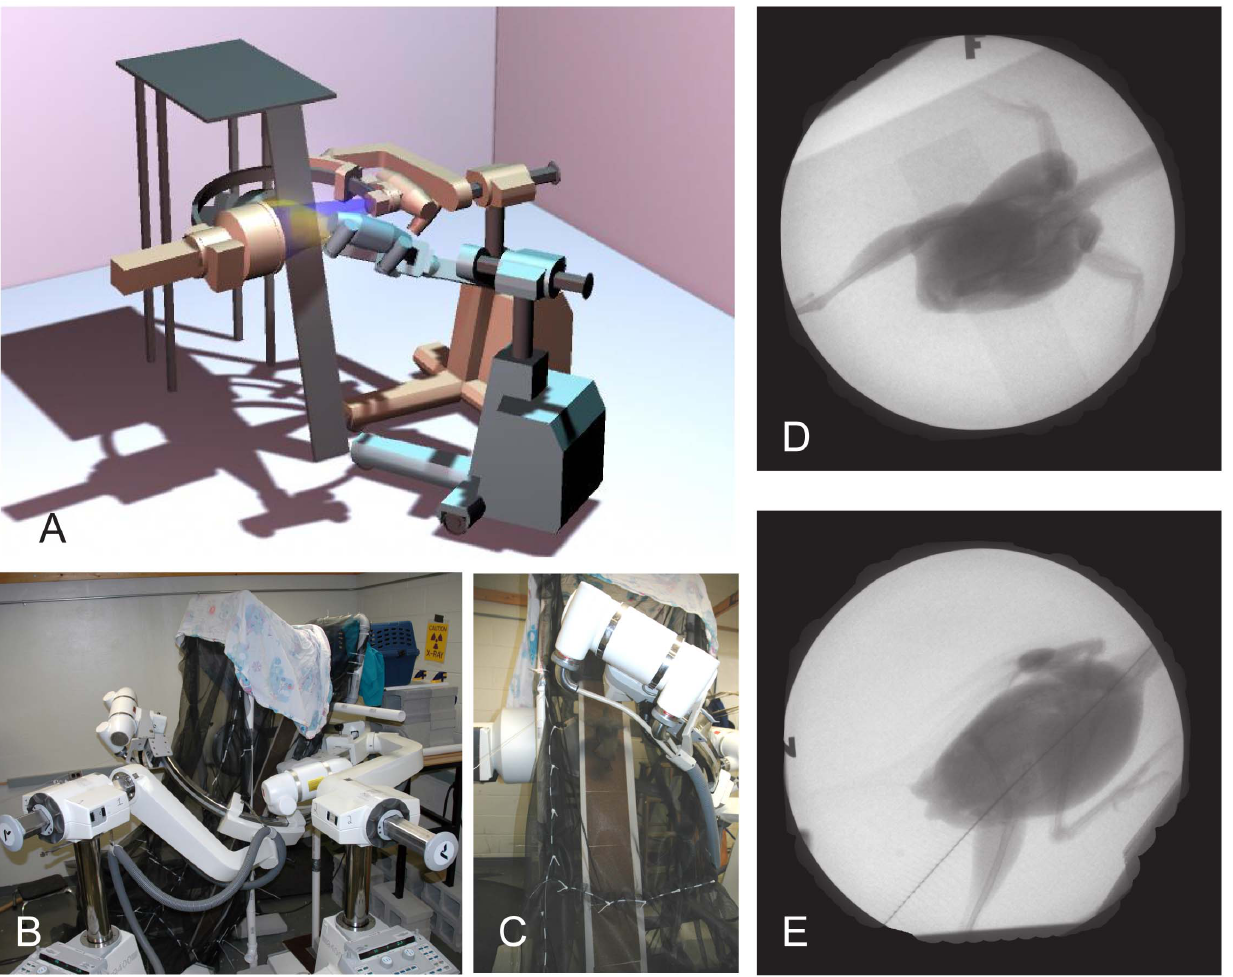
Figure 1. Experimental setup. A. 3-D model of the experimental setup showing the position of the imaging area of the two X-ray beams (yellow and blue cones). B. the actual setup. C. view from position of the animal handler (chukar on ramp between dual X-ray beams). D. dorsoventral X-ray view. E. lateral X-ray view. Note WAIR images from D and E have been mirrored horizontally.